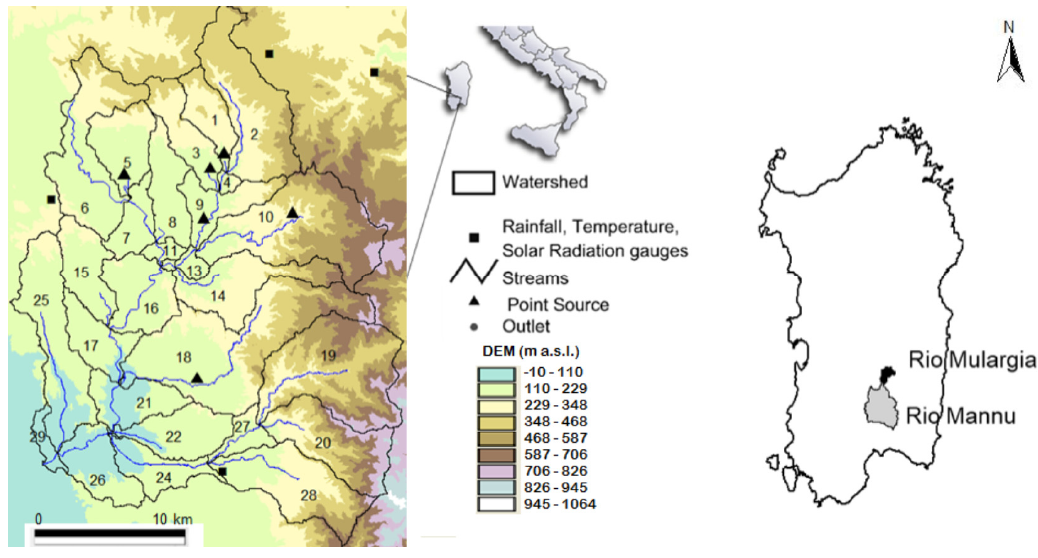
Figure 1. Study area.